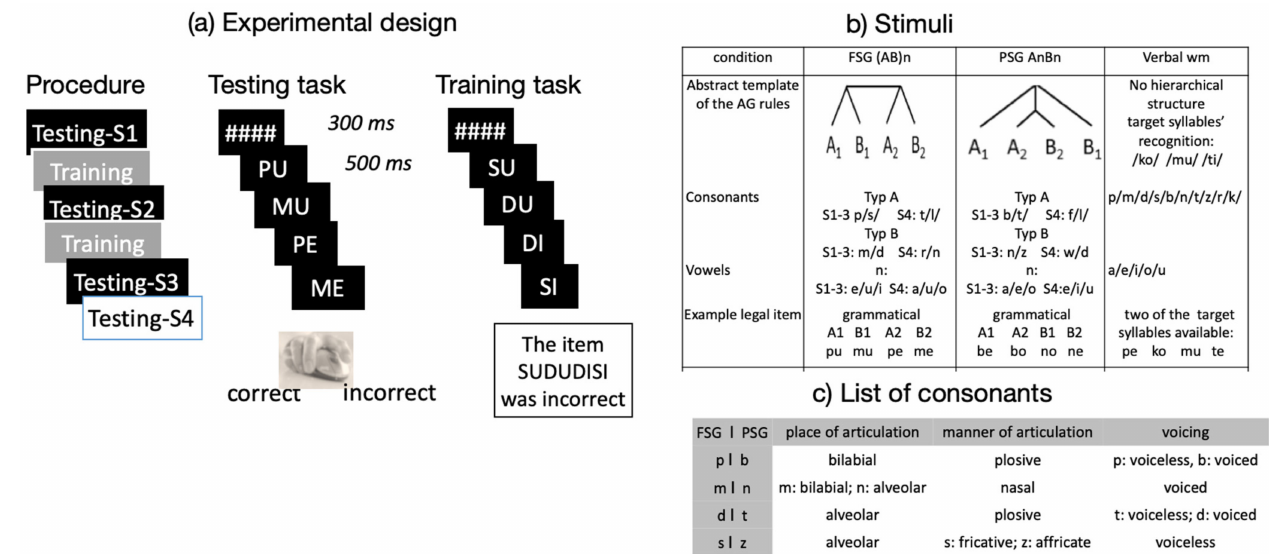
Figure 2. Experimental design and general structure of the stimuli. ( a ) The experiment consisted of three—Finite State Grammar (FSG), Phrase Structure Grammar (PSG) and verbal working-memory (verbal WM)—condition-blocks. Each condition-block included testing sessions and training sessions using the same lexicon (but different items). The fourth testing session of the Artificial Grammar (AG) conditions contains a novel lexicon. In each session, participants’ were asked to press a button on a mouse for correct and another button for incorrect items. ( b ) Grammatical stimuli consisted of syllable sequences observing adherence to a syntactic rule, while in the ungrammatical stimuli, the hierarchical structure was violated by the exchange of two adjacent (in scrambling) or non-adjacent (permutation) elements (vowels or consonants). In the verbal WM condition, the order of the syllables was not relevant, and no abstract template was identifiable. A sequence was defined as correct when it presented at least two of the three target syllables. ( c ) List of consonants used in the AG